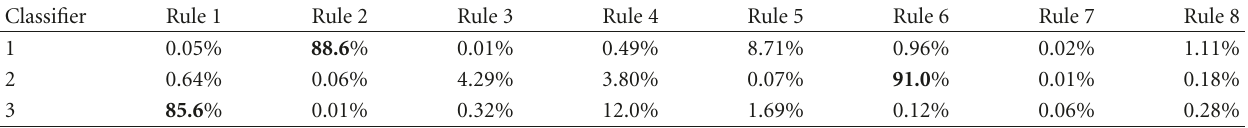
Table 4: Probabilities of using local rules by each classifier for the distributed large rule space.